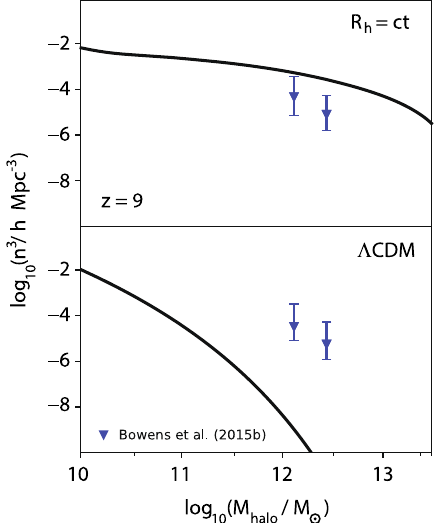
Fig. 4 Top: halo mass function inferred from galaxy surveys at z = 7 compared with R h = ct . Bottom: same, except now for Λ CDM